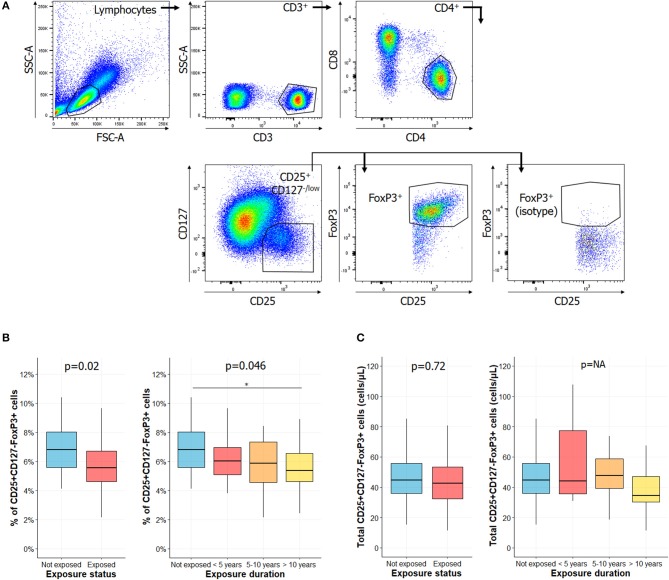
Percentage of regulatory T cell is lower in exposed subjects and decreased with longer CS exposure. (A) Gating strategies for regulatory T cells (Tregs), as described in Santegoets et al. (20): lymphocytes were identified based on their morphology characteristics, as shown in the forward scatter (FSC) and side scatter (SSC) plot. Among these cells, the following populations were successively gated in to identify Tregs: CD3+ cells, CD4+ cells, CD25+CD127−/low, and FoxP3+ cells. Percentage of Tregs among CD4+ cells of subjects exposed or not to silica (B, left) or in subgroups of subjects exposed to silica (B, right). Total counts of circulating Tregs in subjects exposed or not to silica (C, left) or in subgroups of subjects exposed to CS (C, right). Data are shown as boxplot. P-values represent Mann & Whitney test for two groups comparison and, Kruskal-Wallis test for four groups comparison (if previous test significant), followed by post-hoc Dunn test when applicable (results indicated by asterisks, *). P-values have been adjusted according to Hochberg method to account for repeated analysis. NA, not applicable.